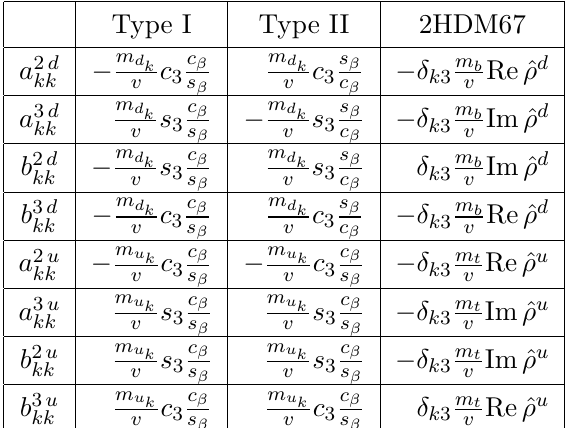
Table 1 . Couplings a (cid:11)q